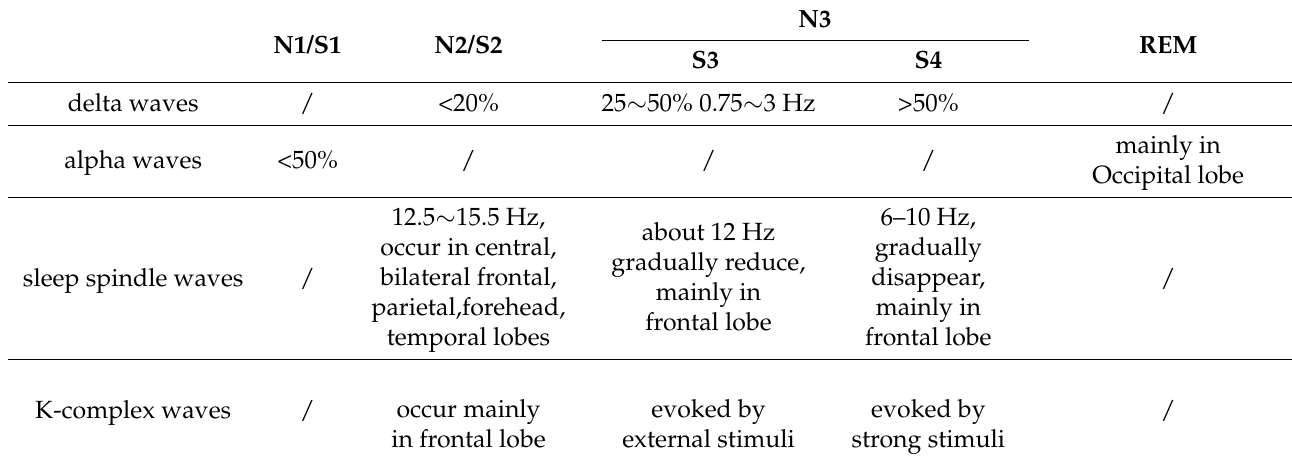
Table 1. Types and spatial distributions of brain waves during stages of sleep, ‘/’ means no appearance.